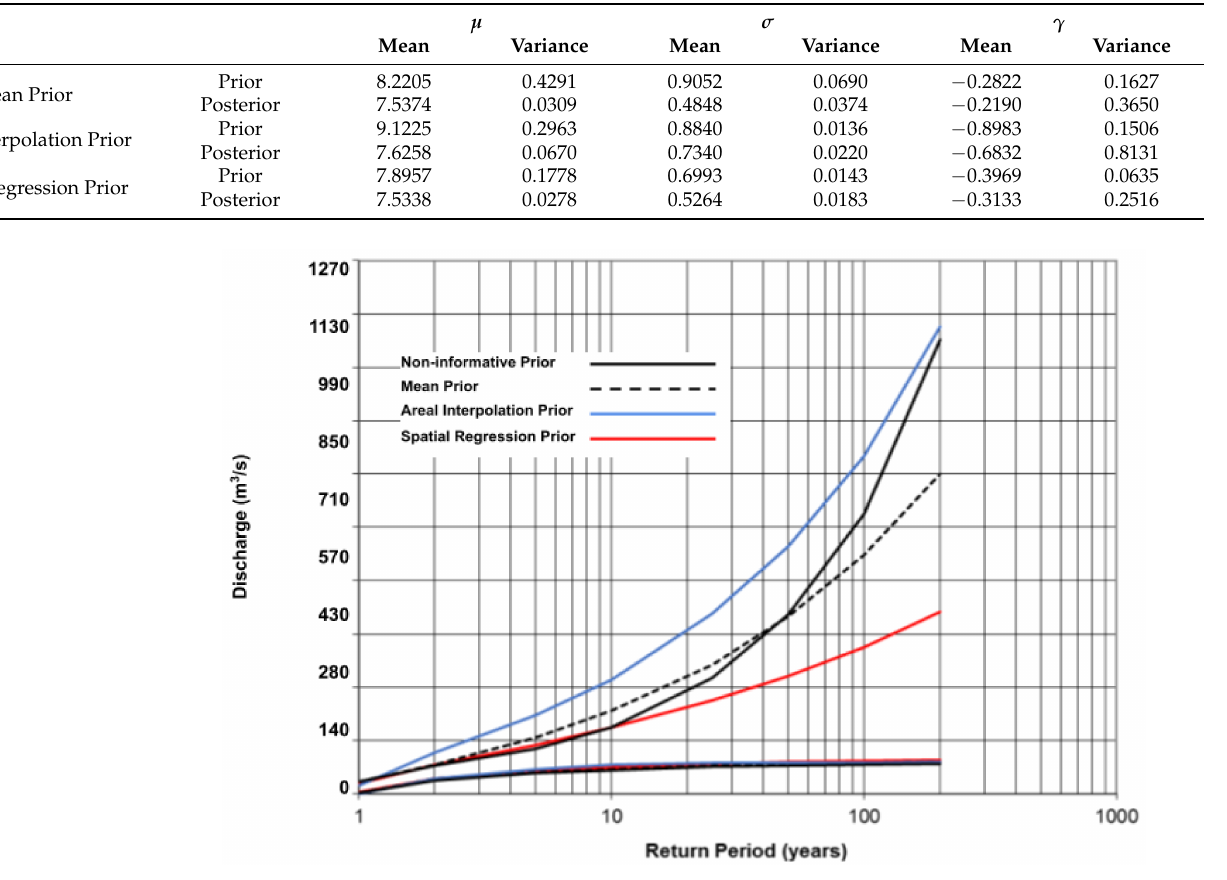
Figure 5. The 95% confidence interval for four scenarios: non-informative prior, mean prior, areal interpolation priors, and spatial regression